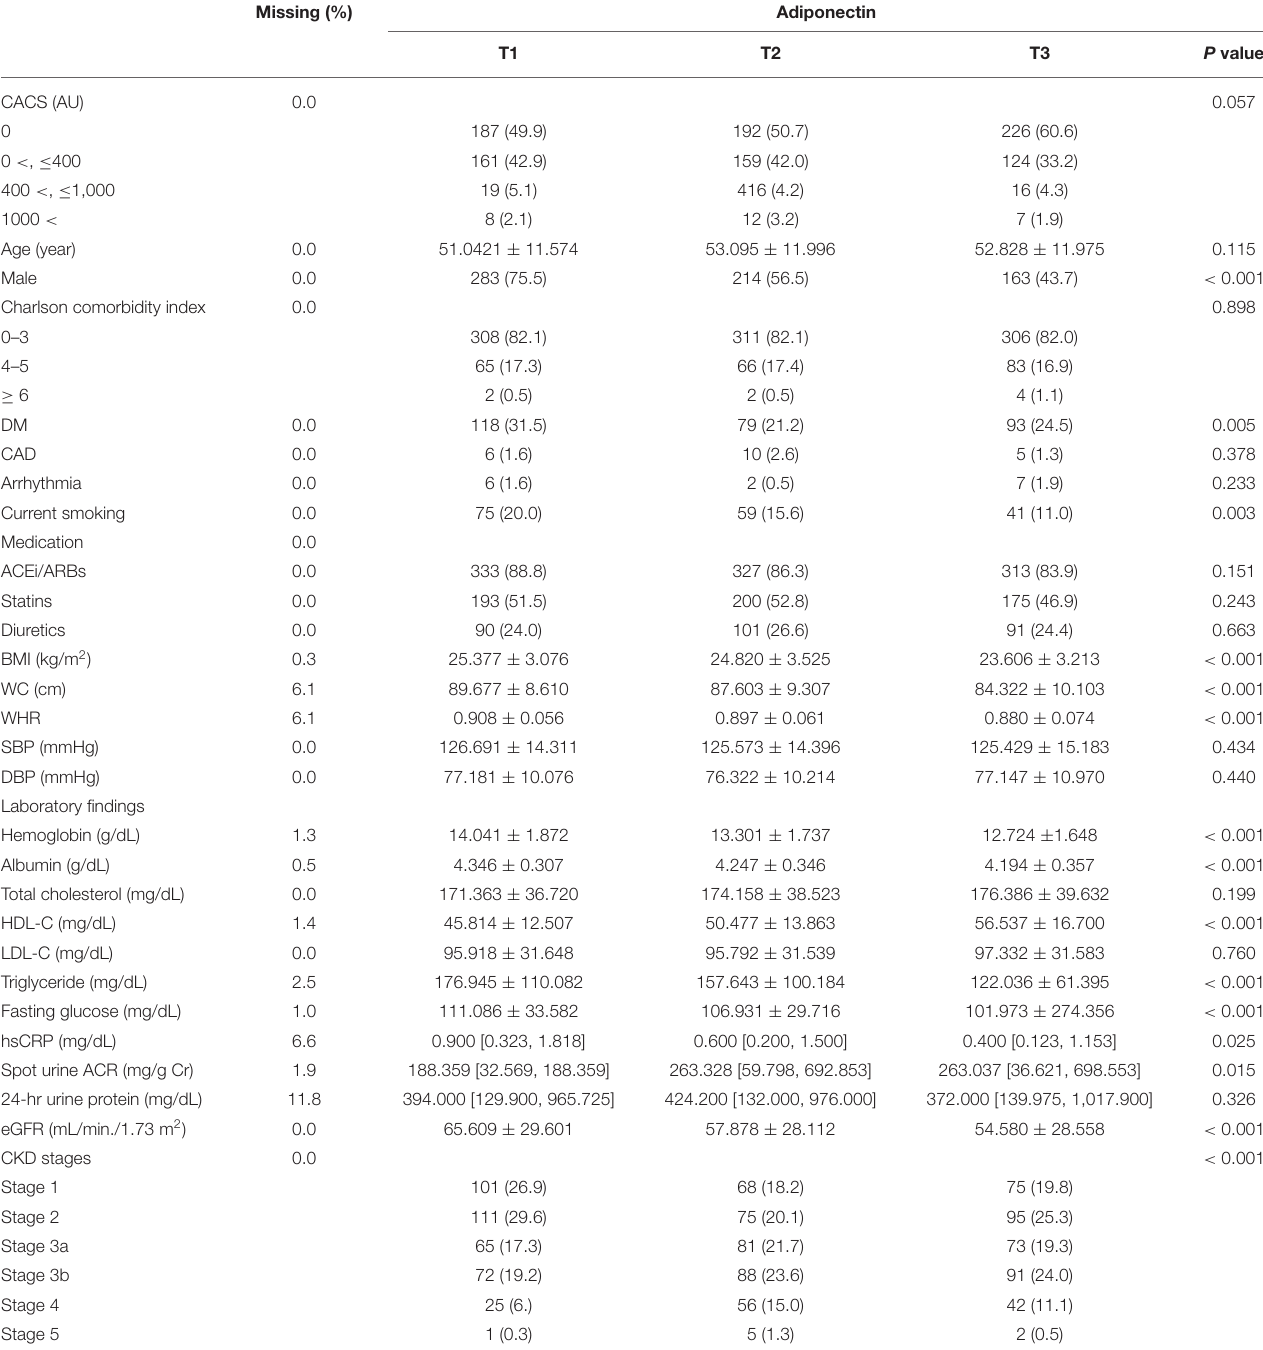
TABLE 1 | Baseline characteristics of study participants in the tertile by serum adiponectin level. Missing (%) Adiponectin